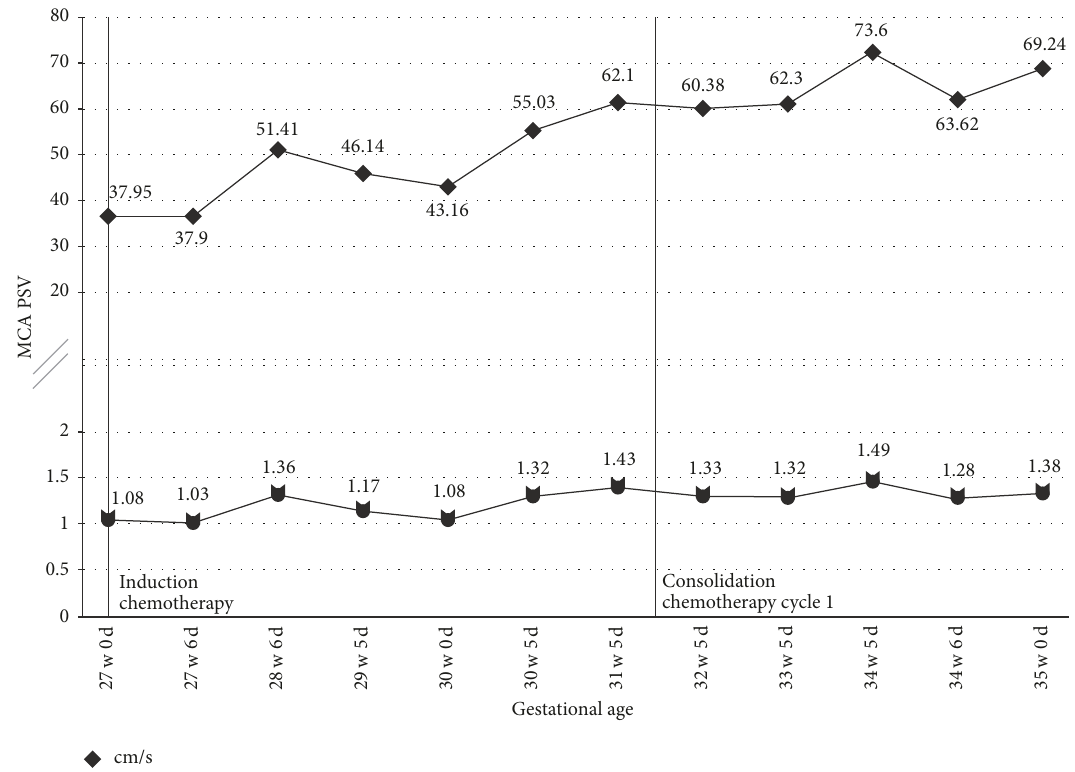
Figure 2: MCA PSV measurements for Case 2. Vertical lines indicate the time of chemotherapy administration. PSVcm/s, peak systolic velocity measurement; MoM, multiples of mean of PSV measurement for corresponding gestational